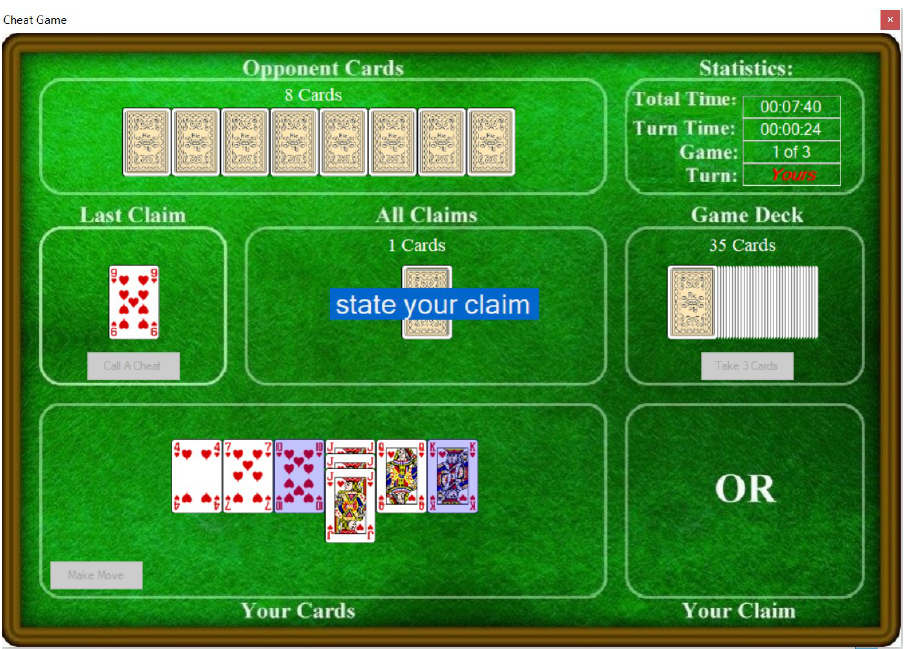
Figure 1. The “Cheat-Game” interface.